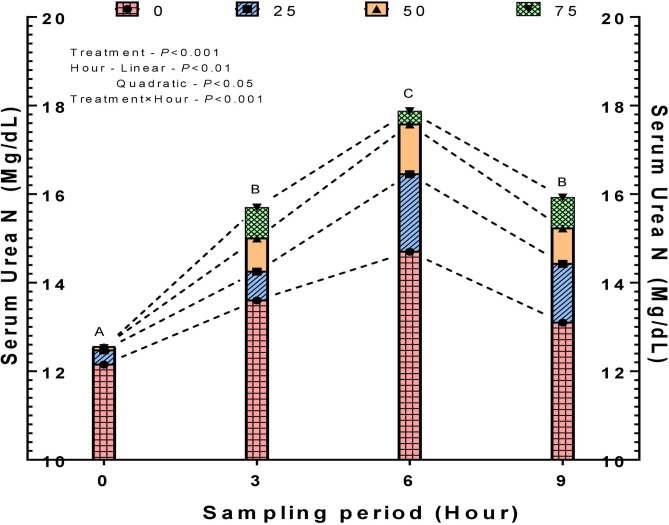
Mean serum urea nitrogen as a function of time and replacements of soybean meal (R2 = 0.838; SUN = 10.276+1.282×SRU+0.529×SRU×TIME+0.801×TIME–0.100×TIME2).